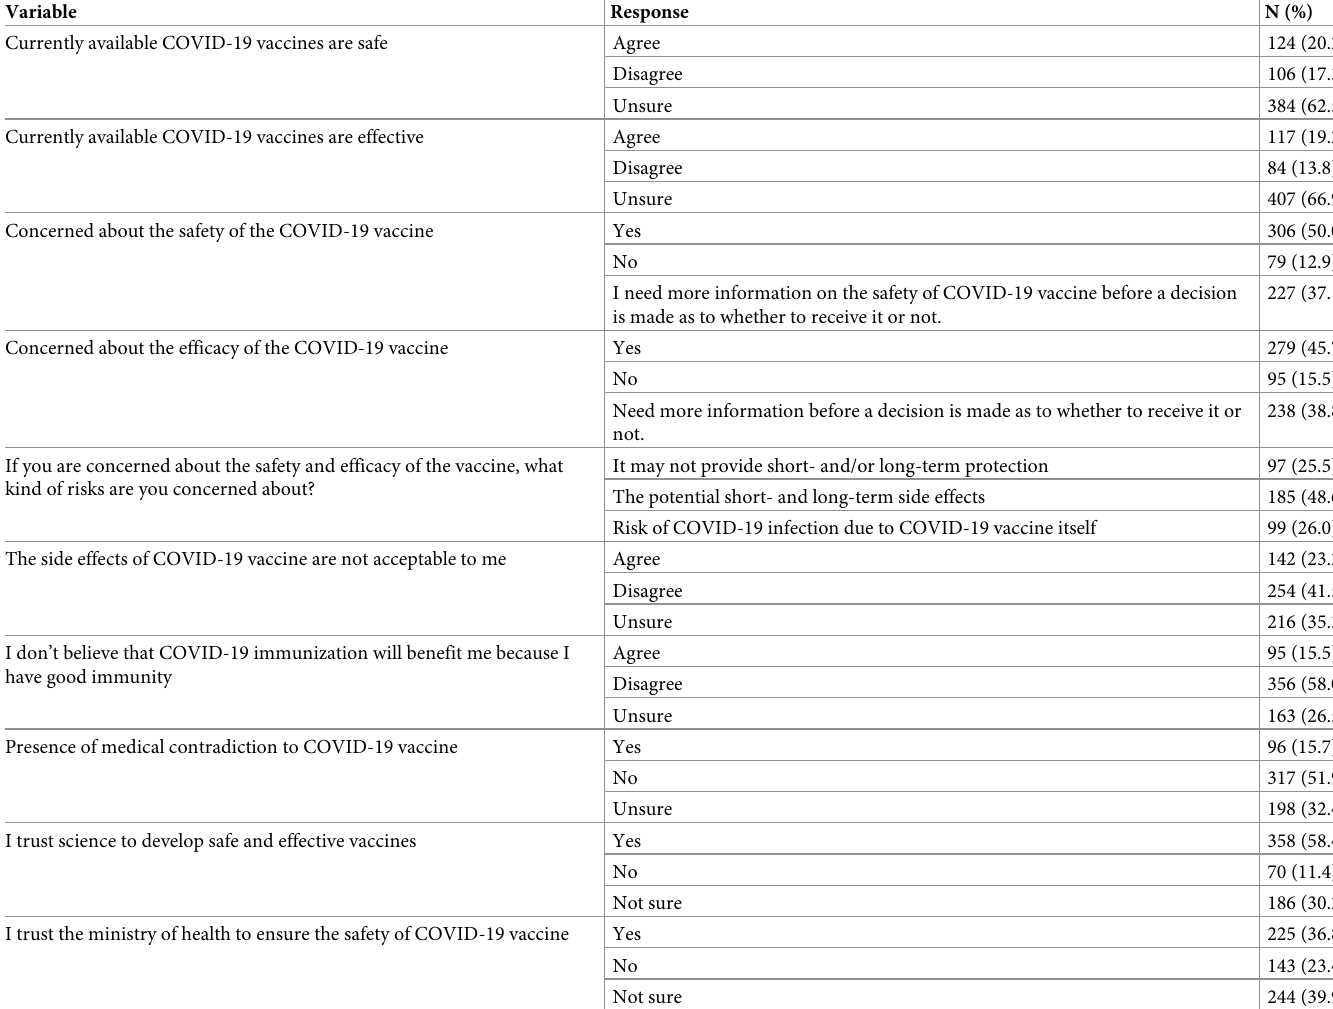
Table 5. Perceived concerns of healthcare providers regarding COVID-19 vaccine.